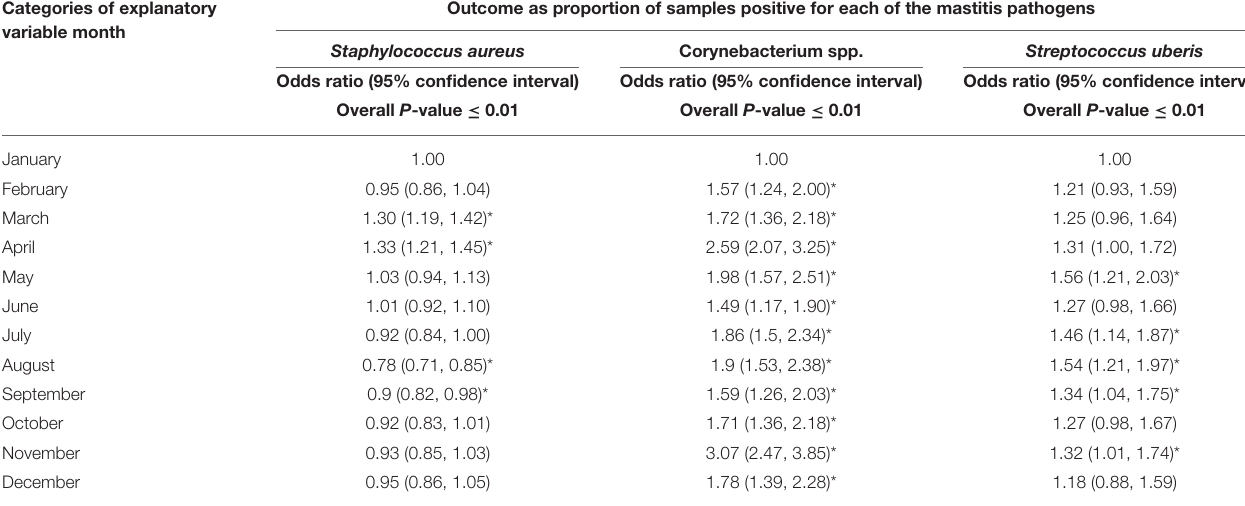
TABLE 6 | Regression analysis of the proportion of samples positive for various mastitis pathogens by month. Categories of explanatory Outcome as proportion of samples positive for each of the mastitis pathogens variable month Staphylococcus aureus Corynebacterium